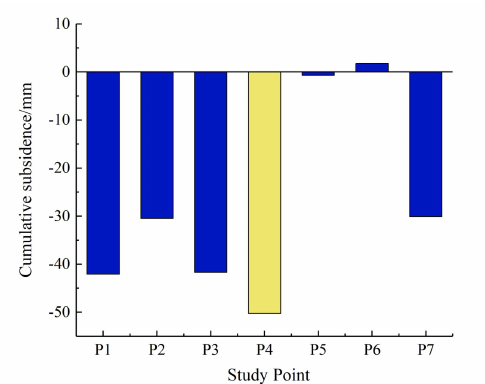
Figure 11. The final cumulative surface subsidence of each study point